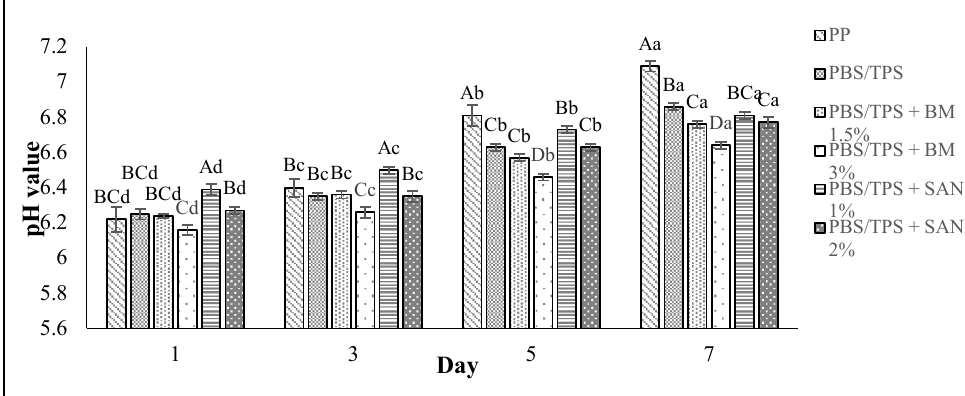
Figure 4. The pH values of chicken breast fillets stored in PP container and PBS/TPS film laminated tray during storage at 4 °C for seven days. Note: PP: polypropylene microwavable container (control); PBS/TPS: PBS/TPS film (untreated); PBS/TPS + BM 1.5%: PBS/TPS film + 1.5% Biomaster silver; PBS/TPS + BM 3%: PBS/TPS film + 3% Biomaster silver; PBS/TPS + SAN 1%: PBS/TPS film + 1% SANAFOR; PBS/TPS + SAN 2%: PBS/TPS film + 2% SANAFOR. Error bars indicate standard deviation (n = 3). The different A–D capital letters are significantly different ( p < 0.05) among treatment for each day. The different a–d lowercase letters are significantly different ( p < 0.05) among storage day for each sample.